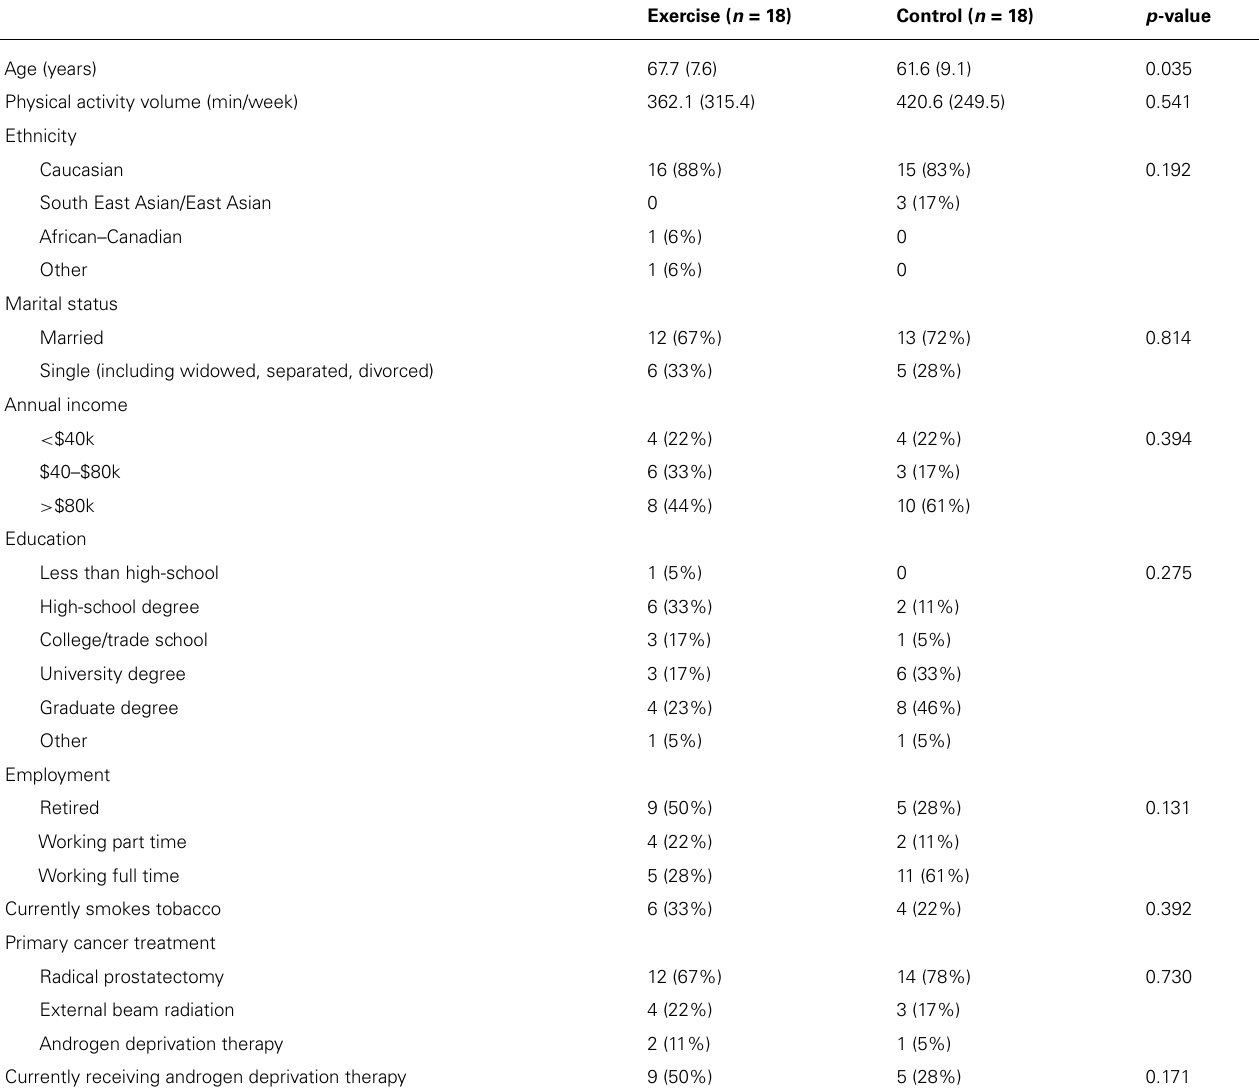
Table 1 | Demographic characteristics of study